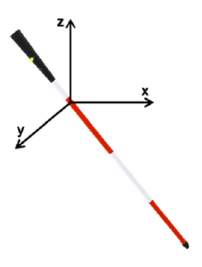
Figure 6. Cane posture in three-dimensional space.